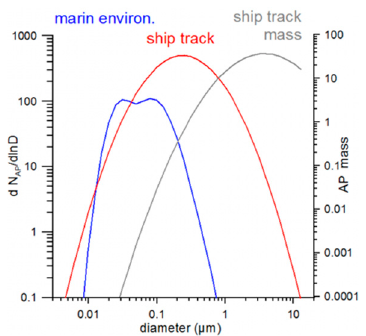
Figure 2. Initial dry aerosol particle number concentration (cm − 3 ) for the marine environment (in blue) and the ship track particles (in red); in gray: the mass of the ship track particles in µg m − 3 (right